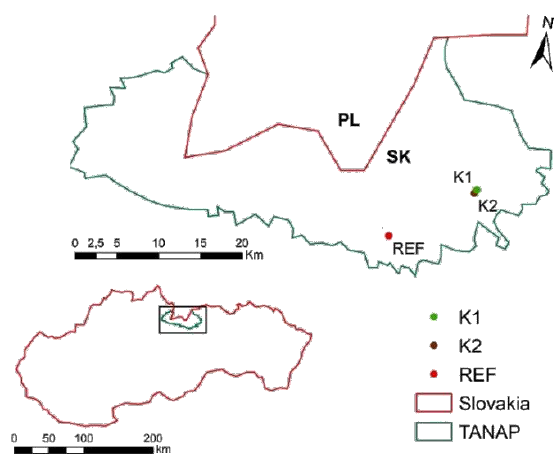
Figure 1. Map of the research area; Tatra Mountains National Park (TANAP), Slovakia (SK). Three types of forest; K1 = attacked by bark beetle, K2 = destroyed by bark beetle, REF = mature forest. Table 1. Mean cover of trees, tree species composition, herb composition, tree regeneration, and coarse woody debris (CWD) in the K1 forest attacked by bark beetle, K2 forest destroyed by bark beetle, and REF mature